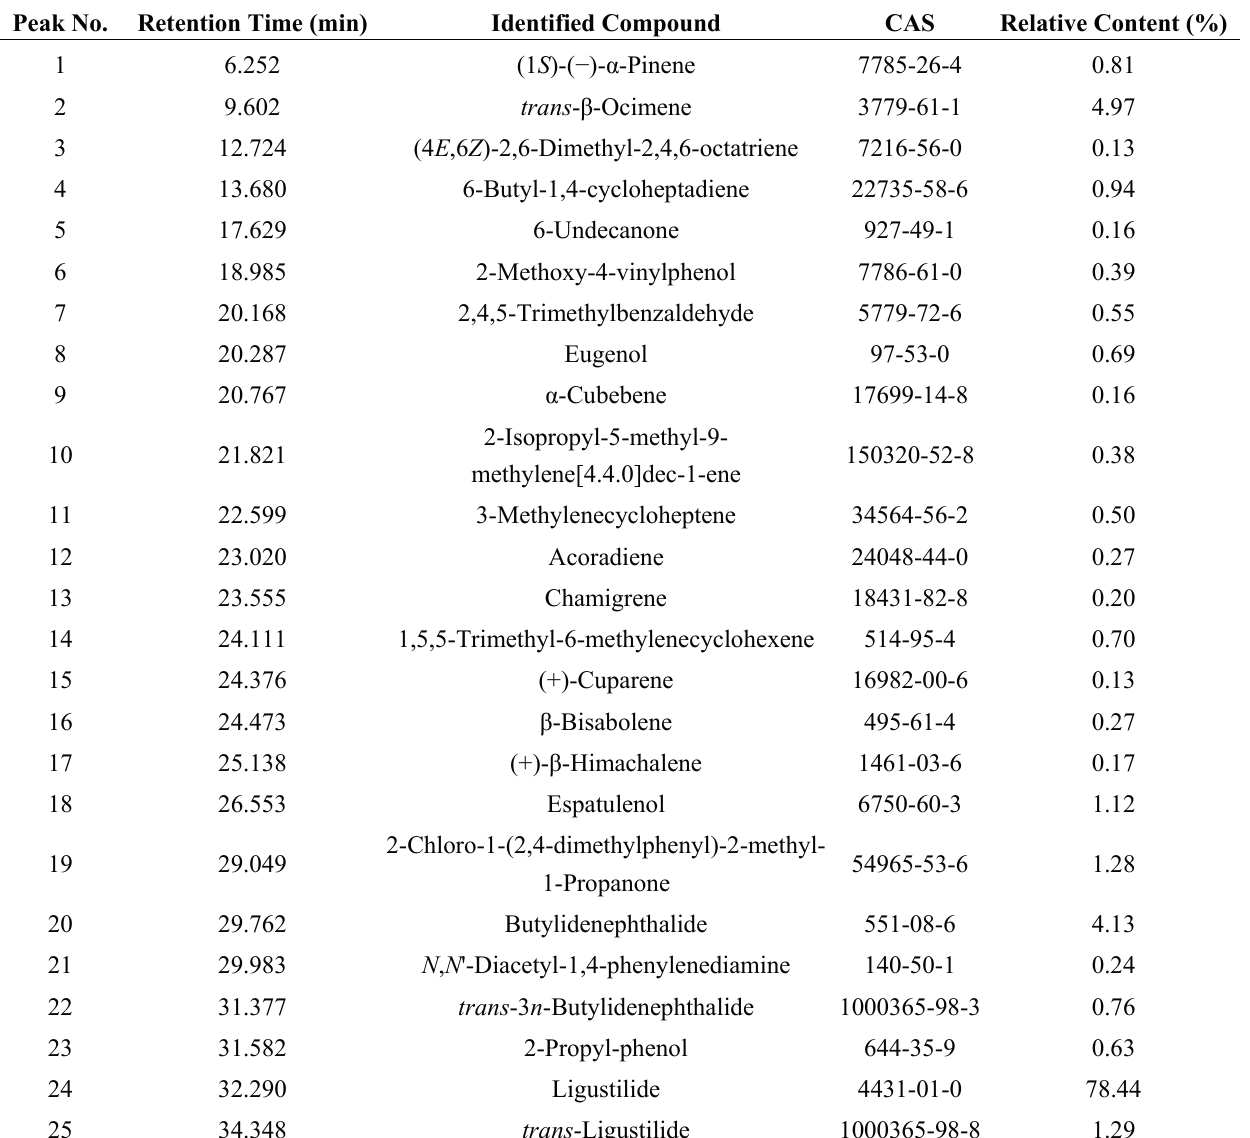
Table 1. Chemical composition of Angelica oil.